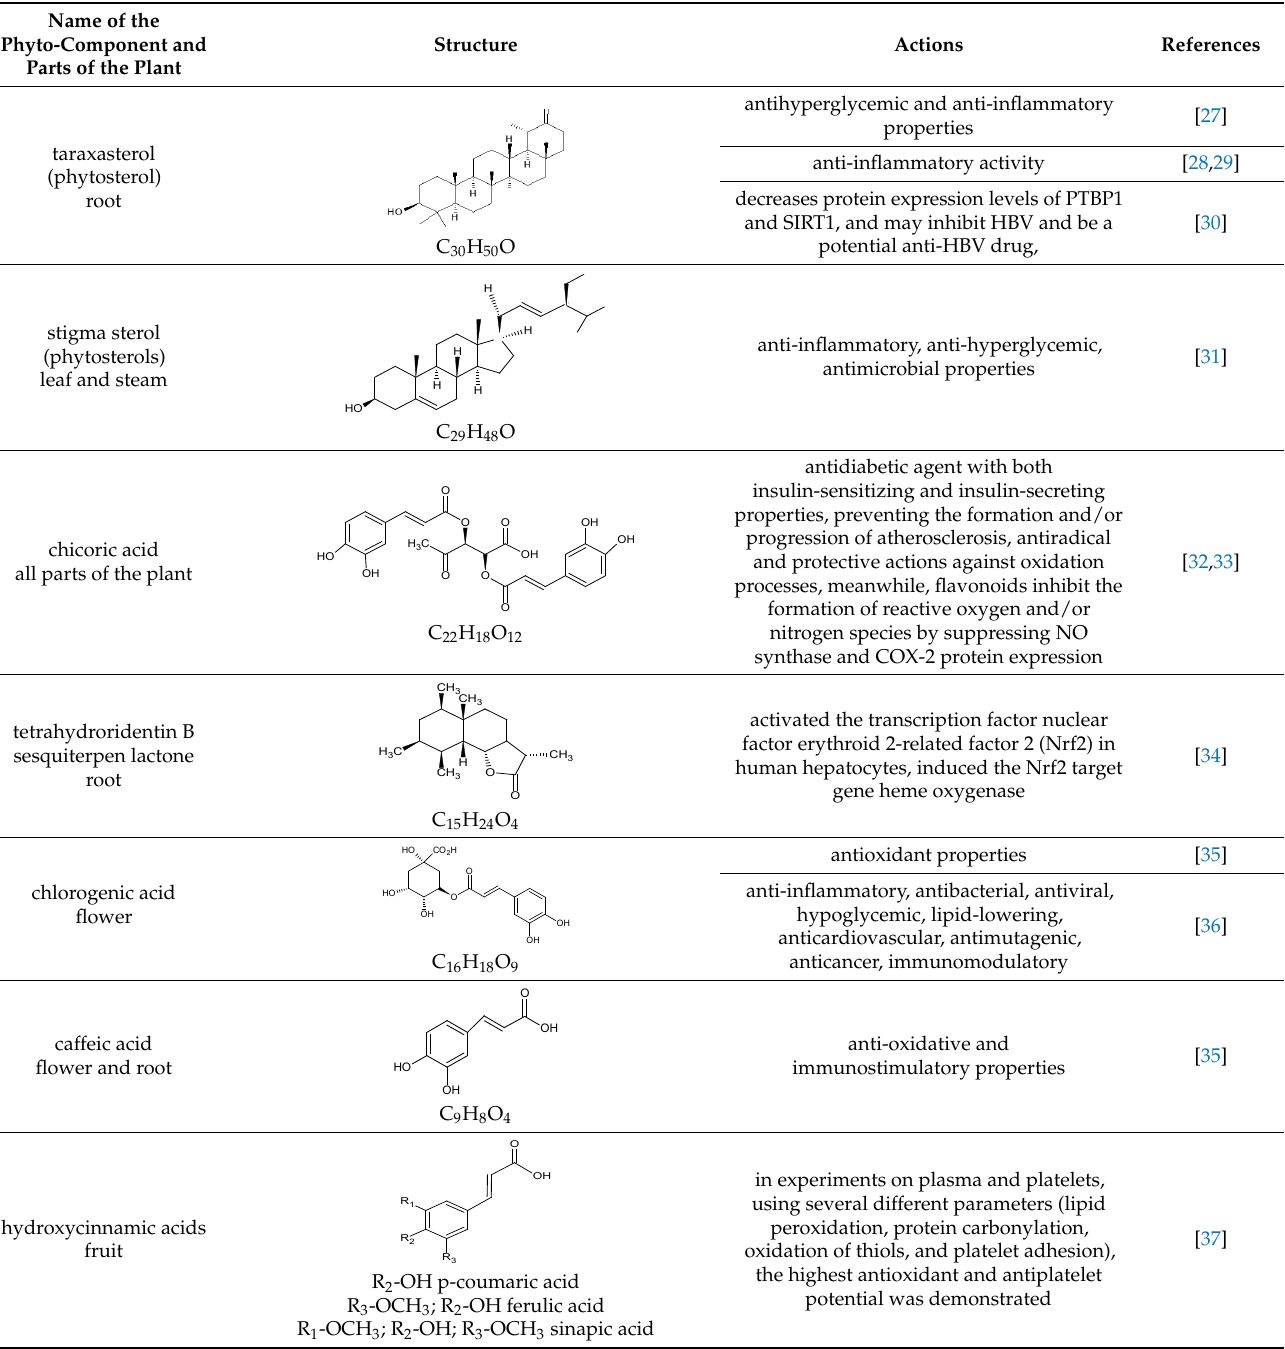
Table 1. Selected phytochemicals of dandelion and their effects .